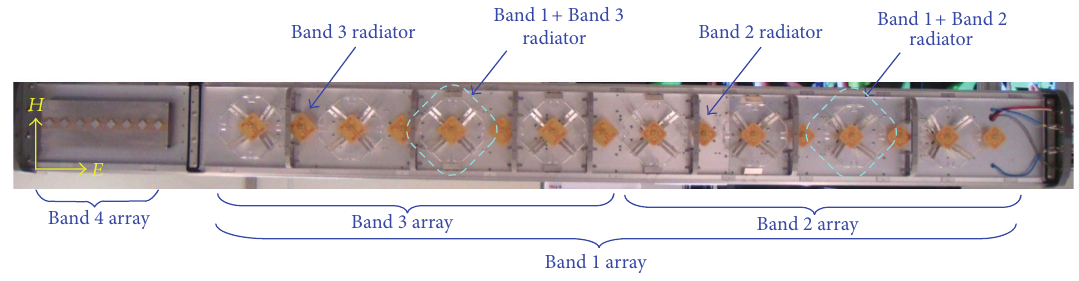
Figure 6: Fabricated multiband array